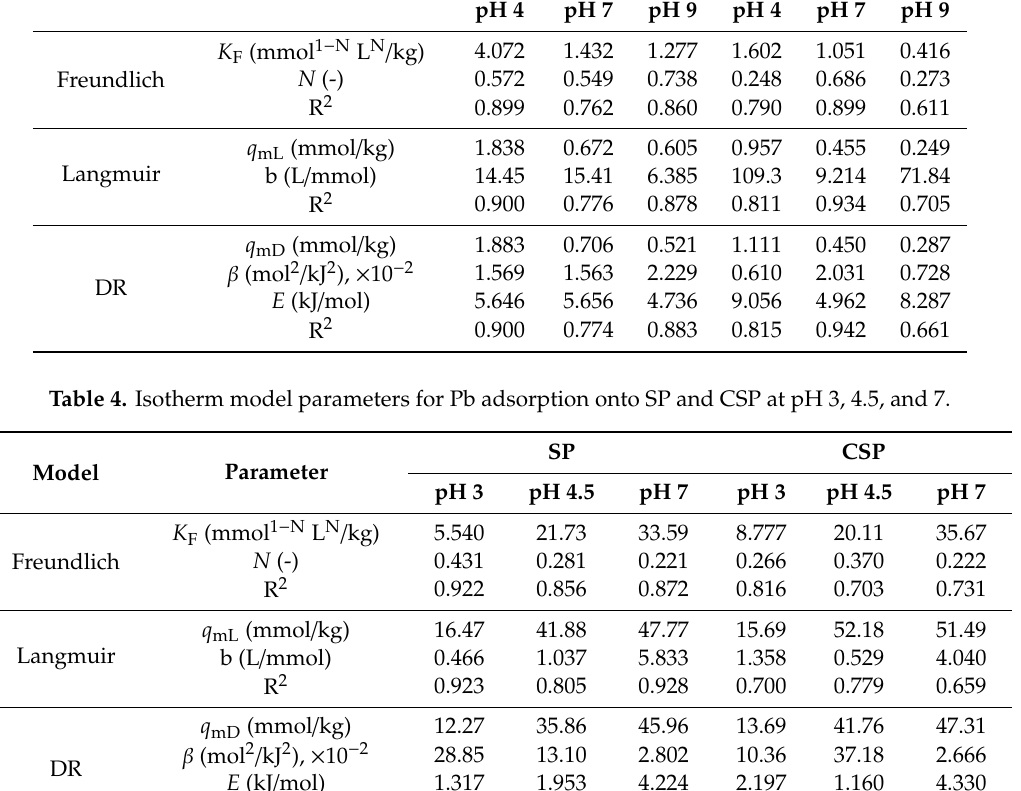
Table 3. Isotherm model parameters for As adsorption onto SP and CSP at pH 4, 7, and 9. Model